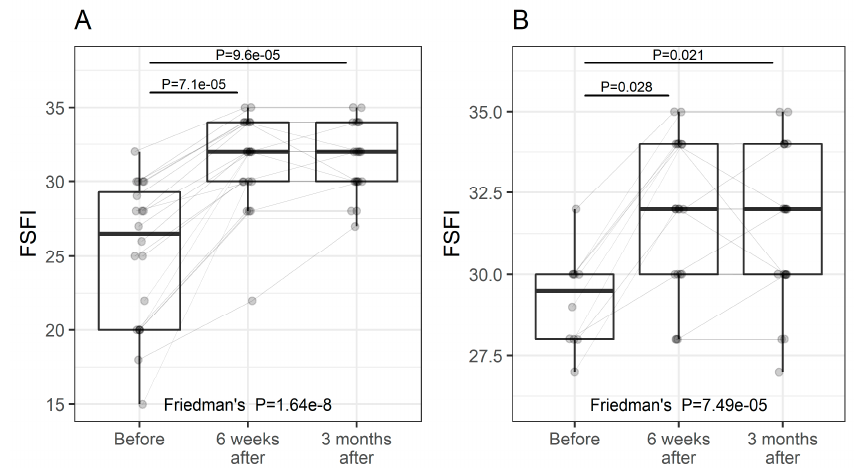
Figure 2. FSFI at study entry and follow-up visits (individual values and summary statistics). ( A )—all participants, ( B )—participants with FSFI score > 26. Individual values are represented by points joined by lines. Summary statistics are shown using boxplots. The middle line of the boxplot is median, the lower and upper hinges correspond to the first and third quartiles (the 25th and 75th percentiles). The upper whisker extends from the hinge to the largest value (no further than 1.5*IQR from the hinge, IQR is the interquartile range—distance between the first and third quartiles). The lower whisker extends from the hinge to the smallest value (no further than 1.5*IQR of the hinge). p -values were determined using Friedman’s test, followed by pairwise post hoc Wilcoxon test with FDR adjustments for multiple testing correction.